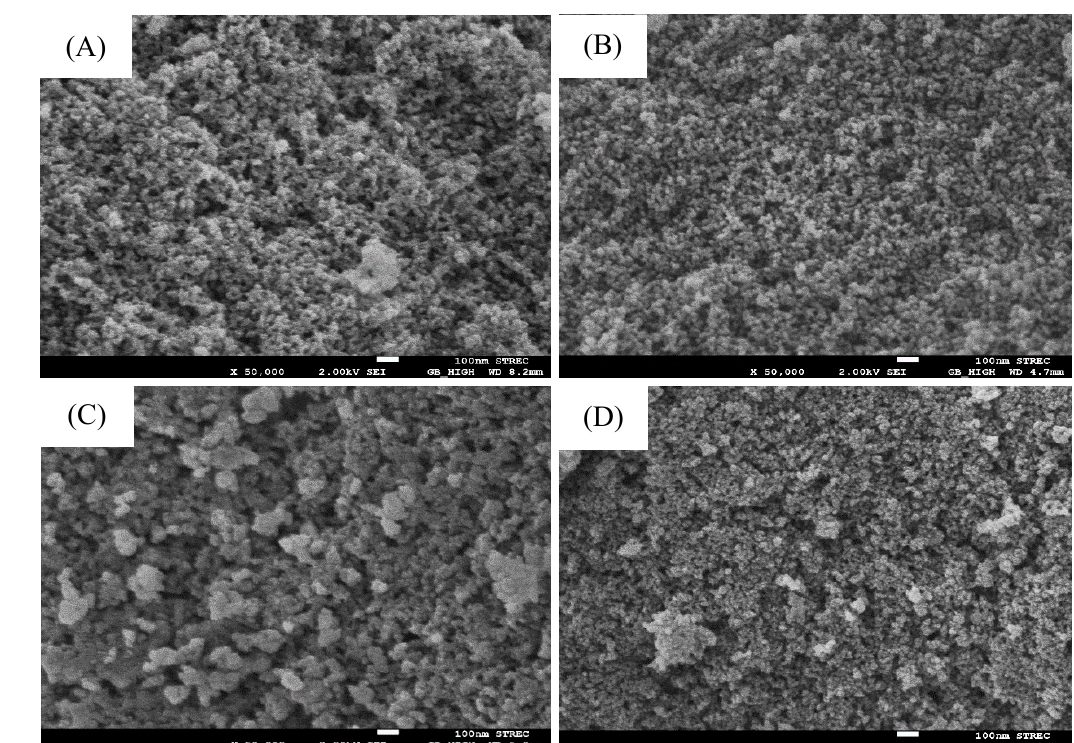
Figure 4. FE-SEM images of ( A ) HMS, ( B ) MCS, ( C ) 10-Nb/HMS, and ( D ) 10-Nb/MCS at magnification of 50,000×. The temperature-programmed desorption of NH 3 (NH 3 -TPD) profiles of representa- tive HMS and MCS catalysts are compared in Figure S3 (SM). The acid sites of Nb/HMS and Nb/MCS catalysts were classified into three types, corresponding to three ranges of desorption temperatures. The desorption occurred at 50–200 °C and was assigned to the